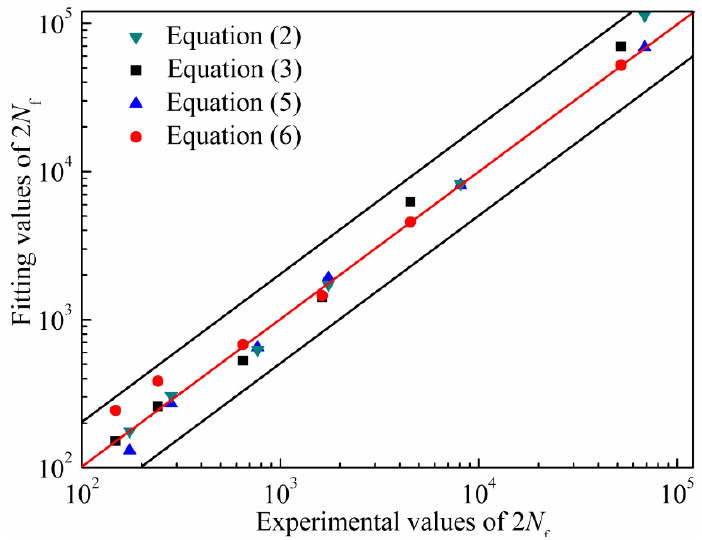
Figure 5. The comparisons of the experimental values and the fitting values.